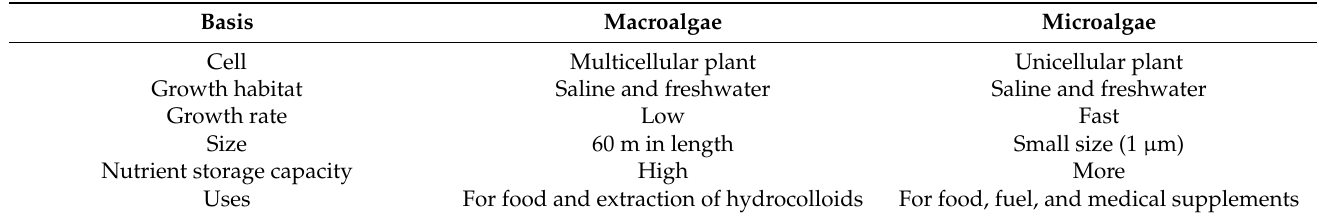
Table 2. Features of microalgae and macroalgae